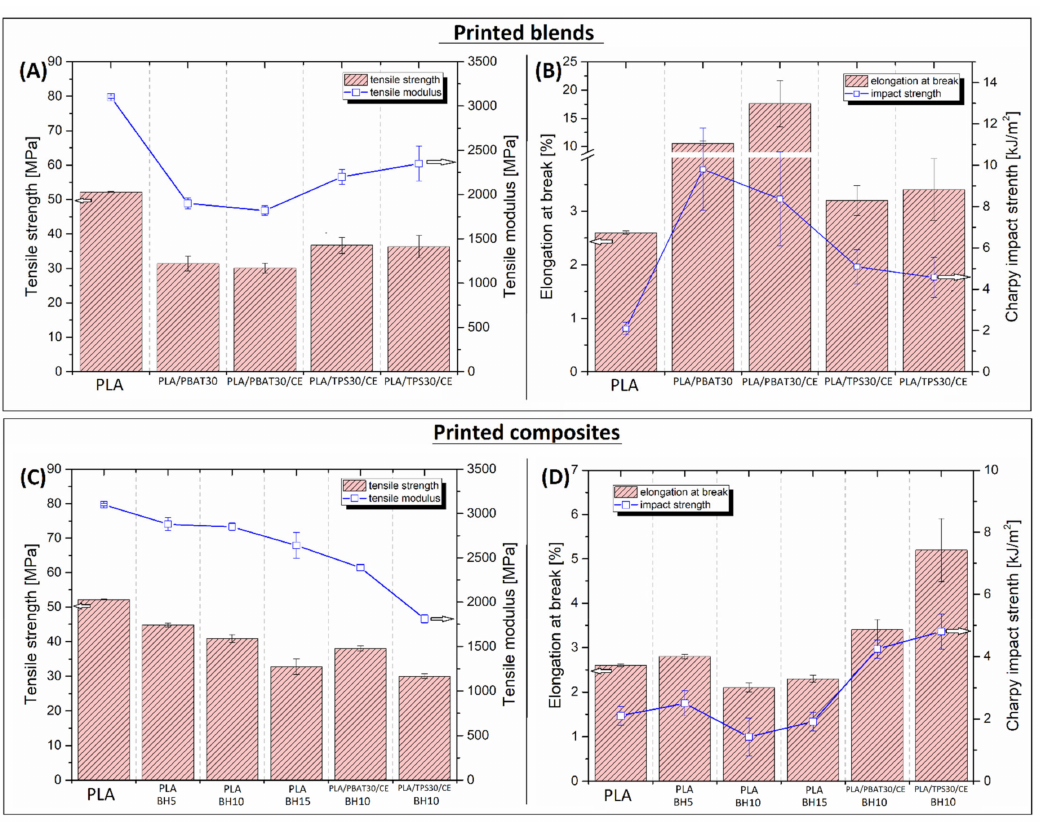
Figure 13. The results of the mechanical tests for FDM-printed samples. Plots present the results of the static tensile test and impact resistance measurements in the form of tensile modulus, tensile strength, elongation at break, and Charpy impact strength. ( A , B ) PLA/PBAT-based samples and ( C , D ) PLA/TPS-based